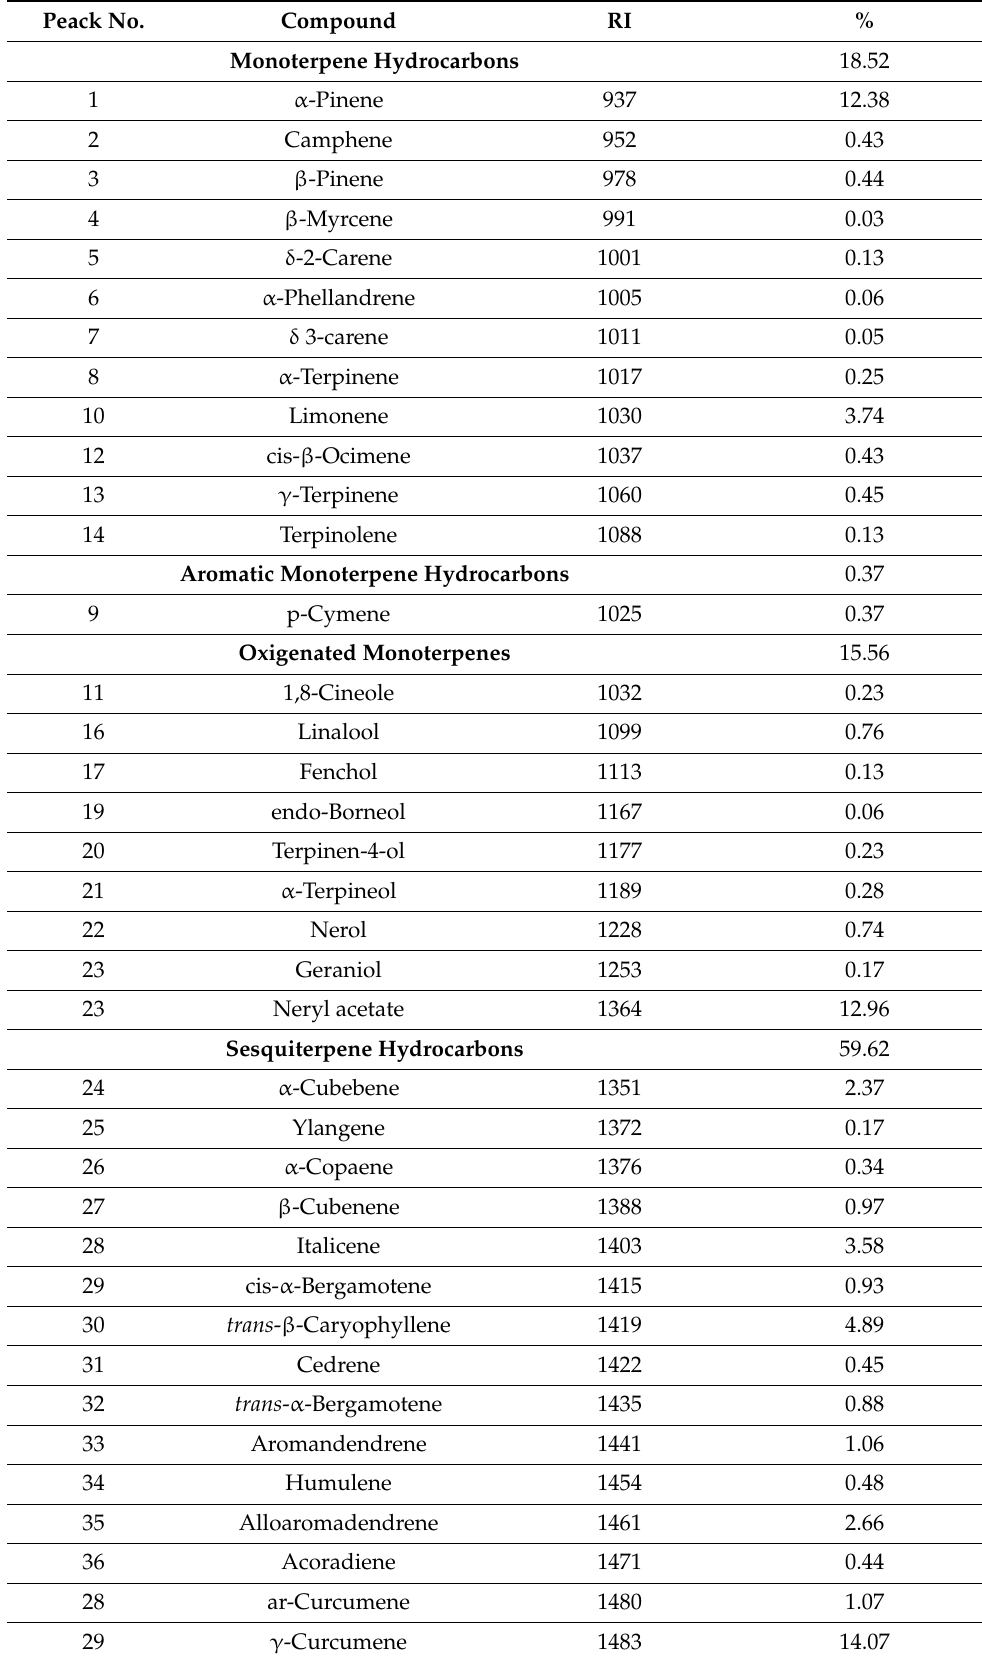
Table 1. Chemical composition of the H. italicum essential